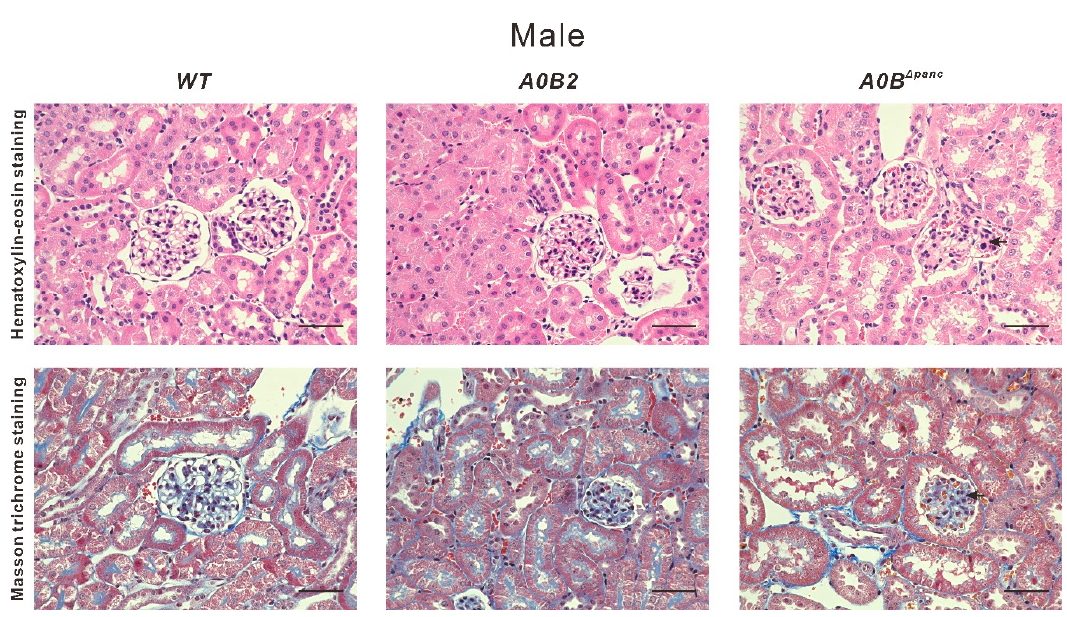
Figure 5. Morphologic comparison of kidneys from male WT , A0B2 and A0B Δ panc mice were performed via staining with hematoxylin–eosin and Masson trichrome. Representative glomeruli are from mice of indicated genotypes at 21 weeks old. Arrows indicate expansion of mesangial matrix and increased collagen in the mesangial matrix, respectively. Scale bar, 50 μ m.